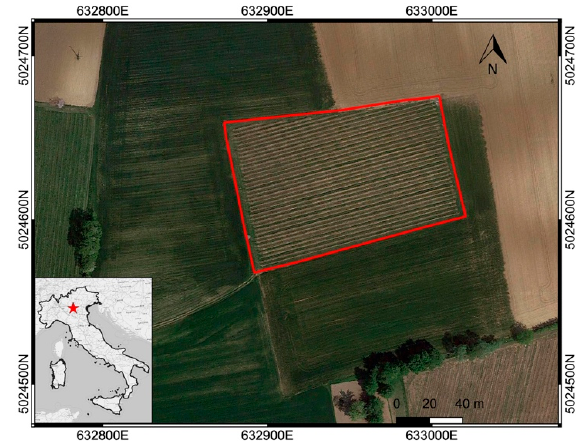
Figure 1. Location of the experimental site.